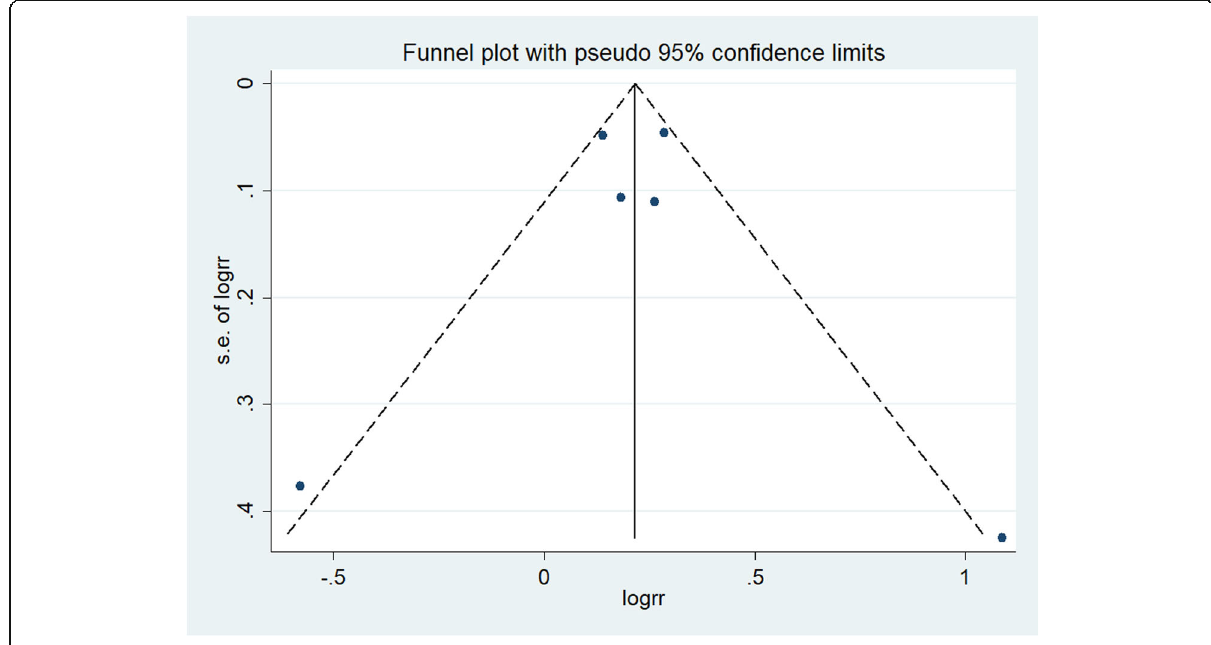
Fig. 4 Funnel plot of log relative risk vs. standard error of log relative risks (for any headache and risk of all-cause dementia)